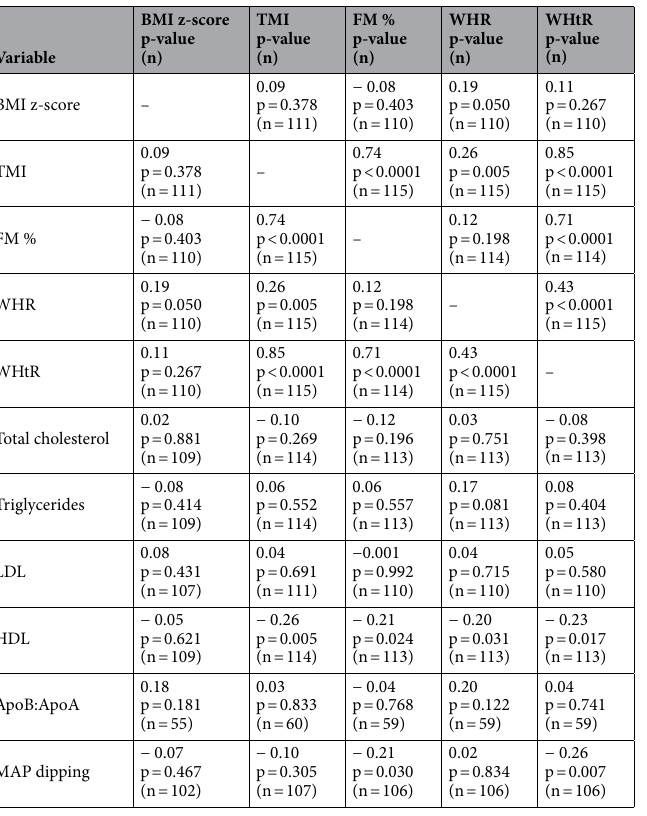
Table 3. Spearman’s correlation of TMI with BMI z-scores, measures of adiposity, lipid profile, and MAP dipping. BMI body mass index, TMI tri-ponderal mass index, FM% fat mass percentage, WHR waist-to-